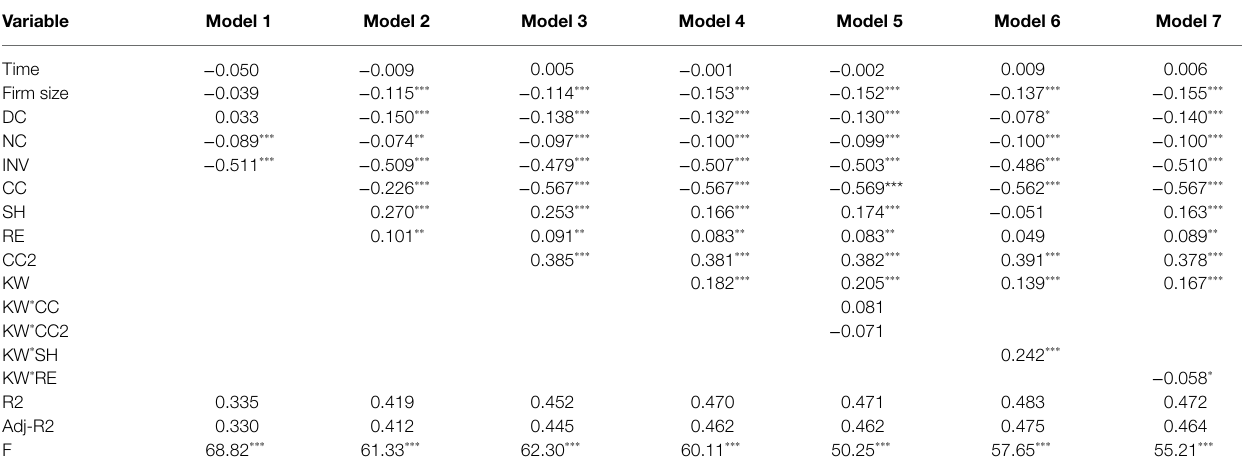
TABLE 3 | Results of hierarchical regression analysis.